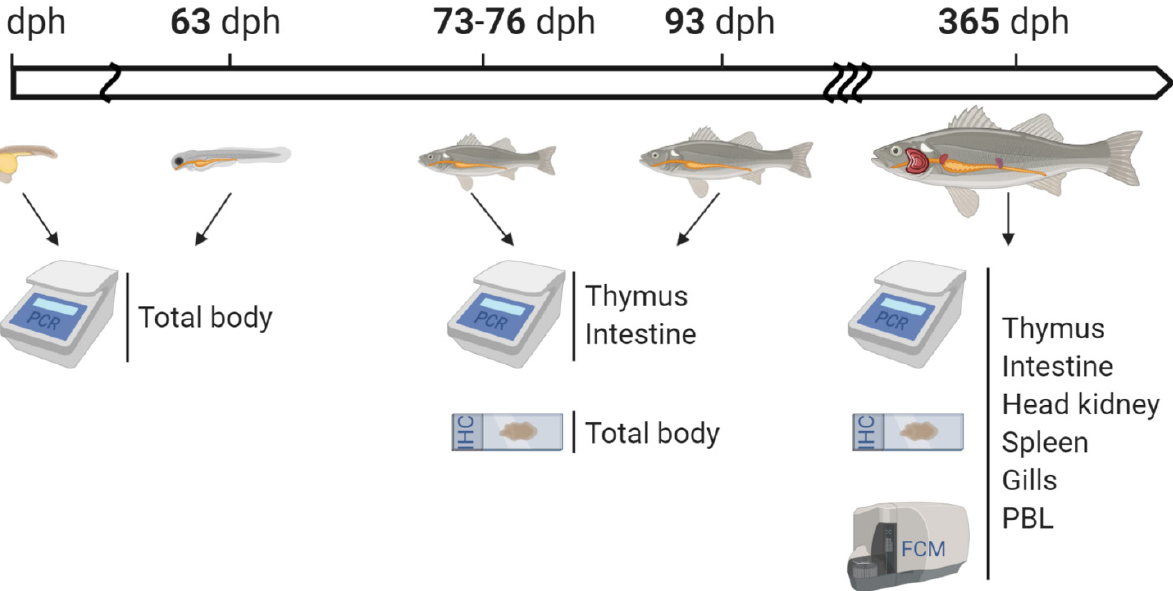
Figure 6. Diagram of the experimental design including ontogeny and juvenile stage details and experimental techniques used. PCR = polymerase chain reaction; IHC = immunohistochemistry; FCM = flow cytometry. PBL was analyzed by PCR and FCM. The illustration was created with BioRender.com.